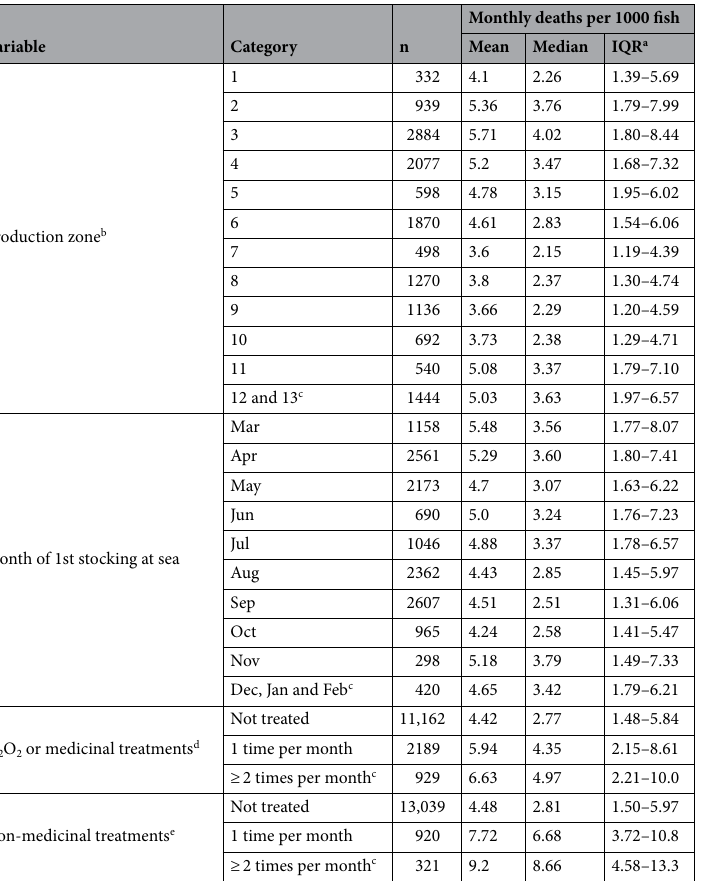
Table 1. Descriptive statistics of categorical explanatory variables versus mortality. a IQR interquartile range. b Production zones delimited in Fig. 6. c Merged category due to few number of observations for one of them. d Bath treatments using H 2 O 2 or medicinal compounds, such as azamethiphos and pyrethroids. lice usually by flushing or brushing, warm water or freshwater